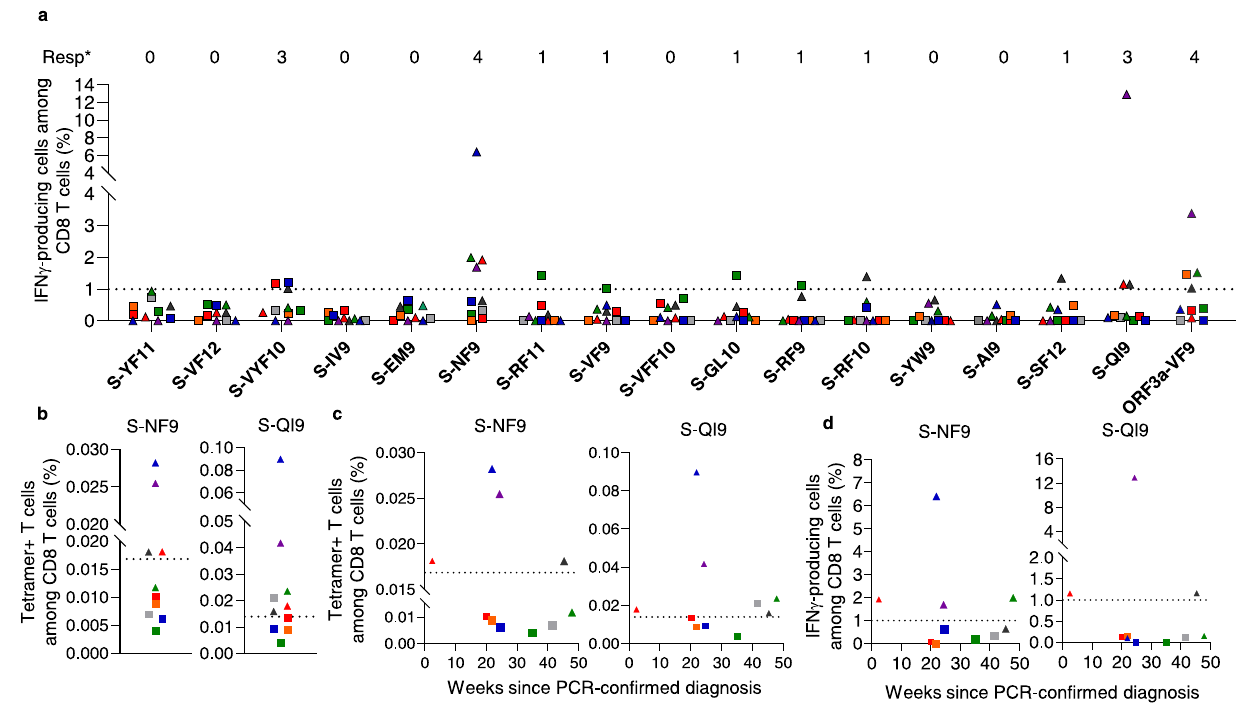
Fig. 5 | HLA-A*24:02-restricted CD8 + T cells elicited in individuals previously infectedwithSARS-CoV-2.a Frequencyofepitope-speci fi cCD8 + Tcellsexpressing IFN- γ in 10 HLA-A*24:02 + individuals previously infected with SARS-CoV-2. The dotted line at 1.0% for IFN- γ -producing cells within the CD8 + T cell population represents the threshold for a positive response. Resp: number of responders. b FrequencyofHLA-A*24:02-S-NF9-tetramer + orHLA-A*24:02-S-QI9-tetramer + CD8 + T cells in ex vivo PBMCs from 10 HLA-A*24:02 + individuals. The dotted line repre- sents the threshold for positive binding. c Correlation between the tetramer-